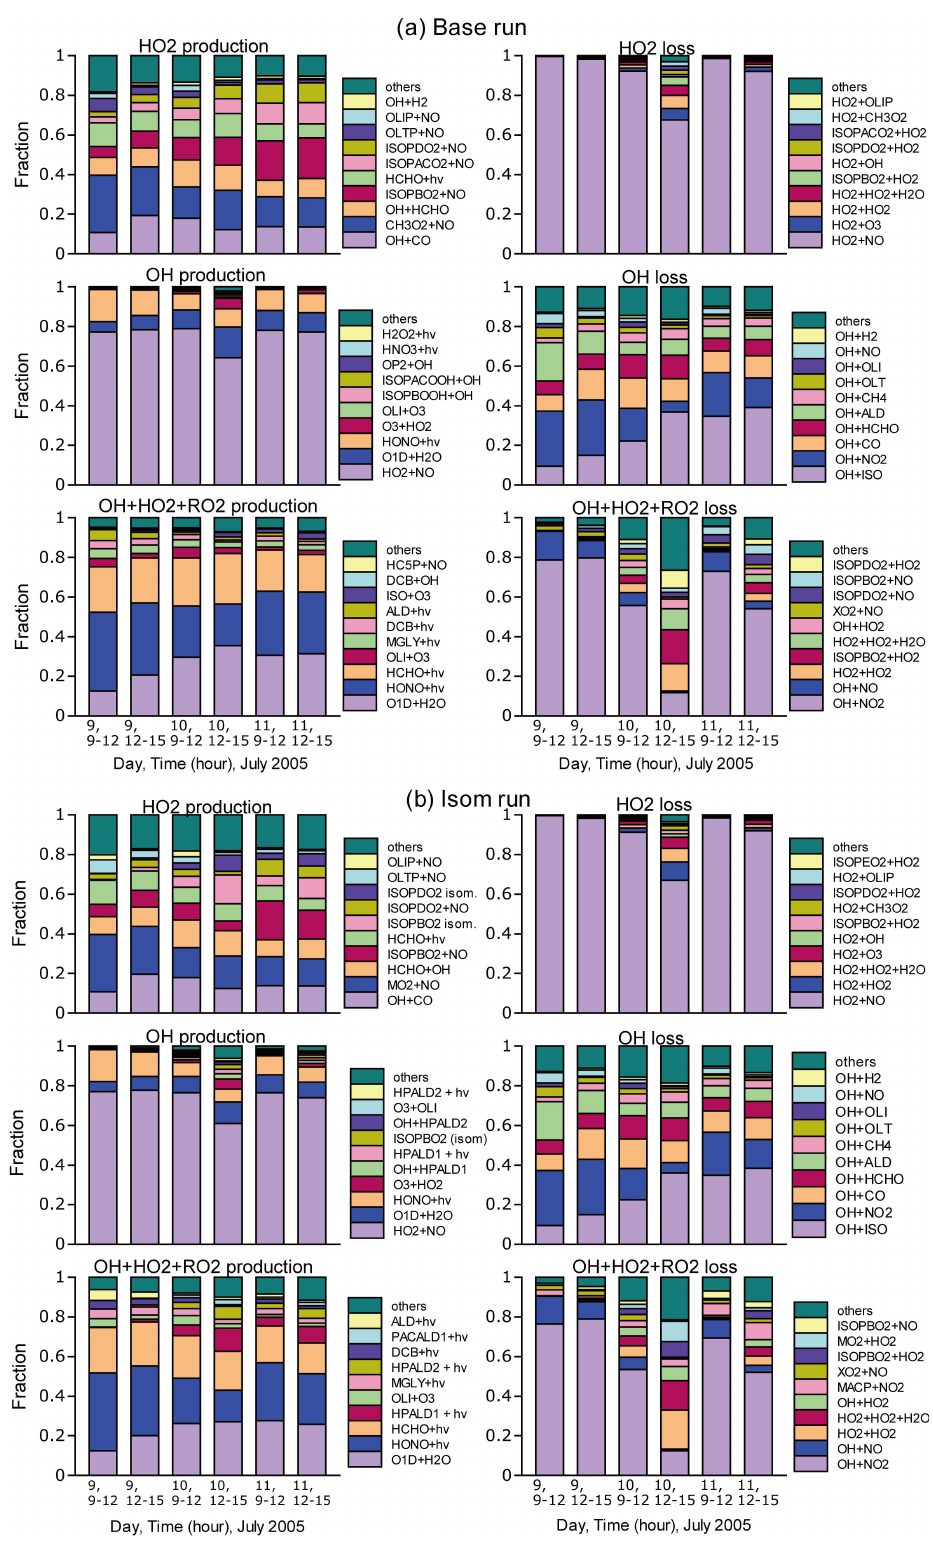
Fig. 4. Breakdown of production and loss processes of OH, HO 2 , and radical group (OH+HO 2 +RO 2 ) in the Base and Isom runs.